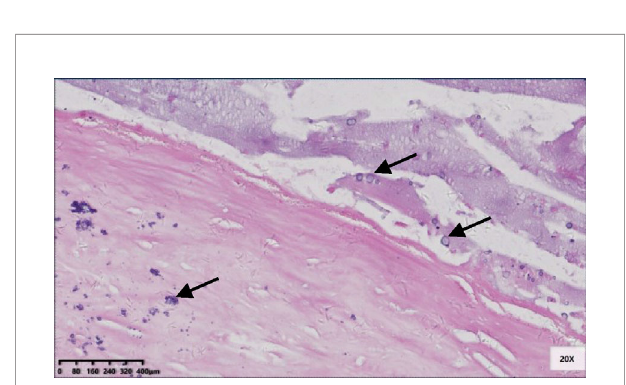
FIGURE 6 | Micro-calci fi cation scattered in the fi brotic appendix wall and in the lumen contents (black arrow) (HE